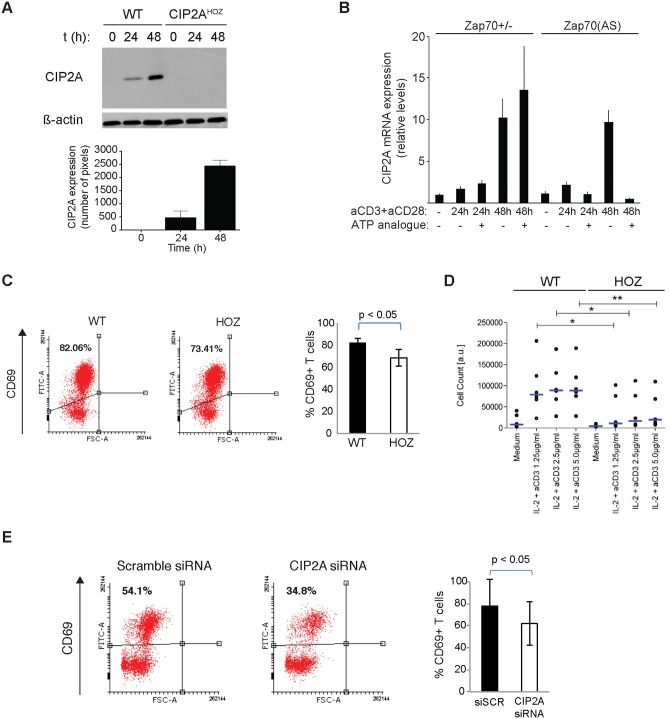
Cell autonomous function for CIP2A in T-cell activation.(A) CIP2A protein expression from activated WT or CIP2AHOZ CD8 T-cells. Mean + S.E.M of CIP2A protein expression using β-actin as a normalization control is shown. (B) CD4+ cells from Zap70+/- or ATP analogue HXJ2-sensitive Zap70(AS) mice were stimulated in vitro with plate-bound anti-CD3 and anti-CD28 antibodies in the presence or absence of HXJ42 (1 μM). Cells were harvested at indicated time-points and shown is real-time PCR analysis of CIP2A transcript levels relative to actin as normalized to the Zap70+/- unstimulated sample. Shown is a representative of two independent experiments with identical results. (C) Cell surface staining of CD69 from CD4+CD62L+ T-cells isolated from WT or CIP2AHOZ mice stimulated with anti-CD3 and anti-CD28 for 24h. The mean + S.E.M. of three independent experiments is shown. Student's t test. (D) Number of viable splenocytes determined by CellTiter-Glo Assay 7 days post-stimulation with IL-2 (20U/ml) and anti-CD3 (1.25, 2.5 or 5 μg/ml). Blue bars indicate medians, circle individual data points (n = 6 for WT & CIP2AHOZ cells). * p<0.05, ** p<0.01, Student’s t-test. (E) Human CD4+ T-cells isolated from umbilical cord blood pooled from 5–6 individuals were nucleofected with scramble nontargeting siRNA or CIP2A siRNA. Cells were rested for 48hrs and activated with anti-CD3 and anti-CD28 for 24h. The mean + S.E.M. of three independent experiments is shown. Student's t test.